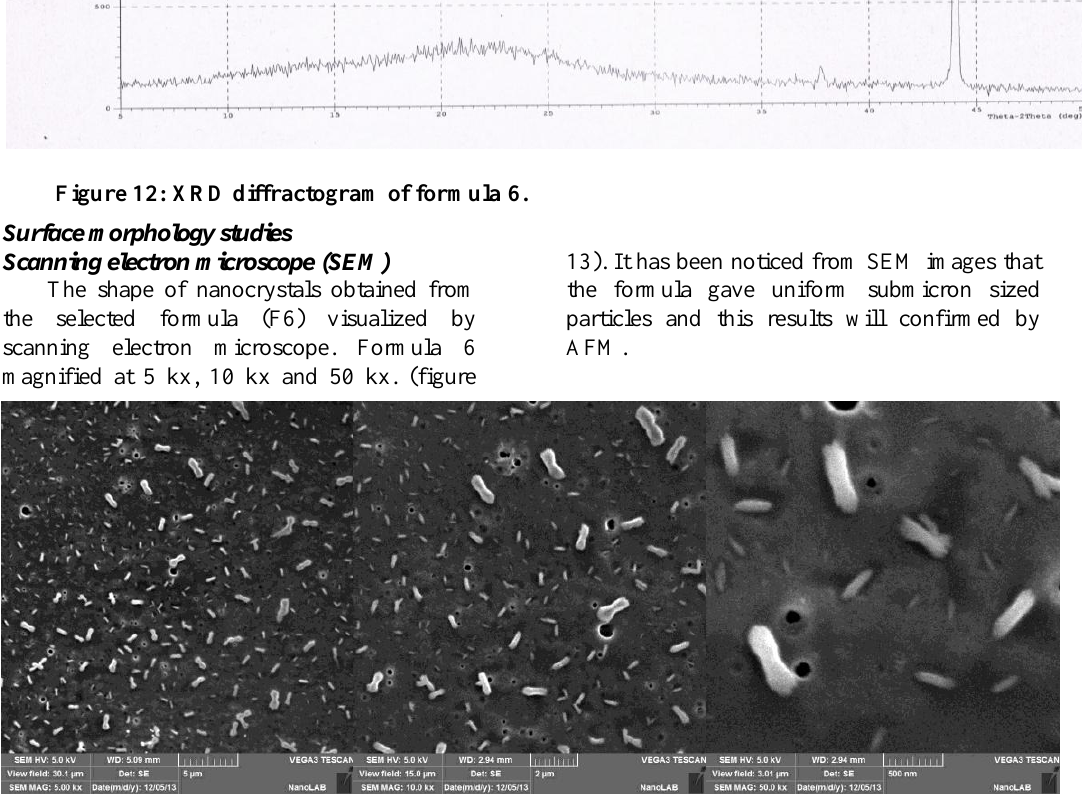
Figure 13: SEM images of